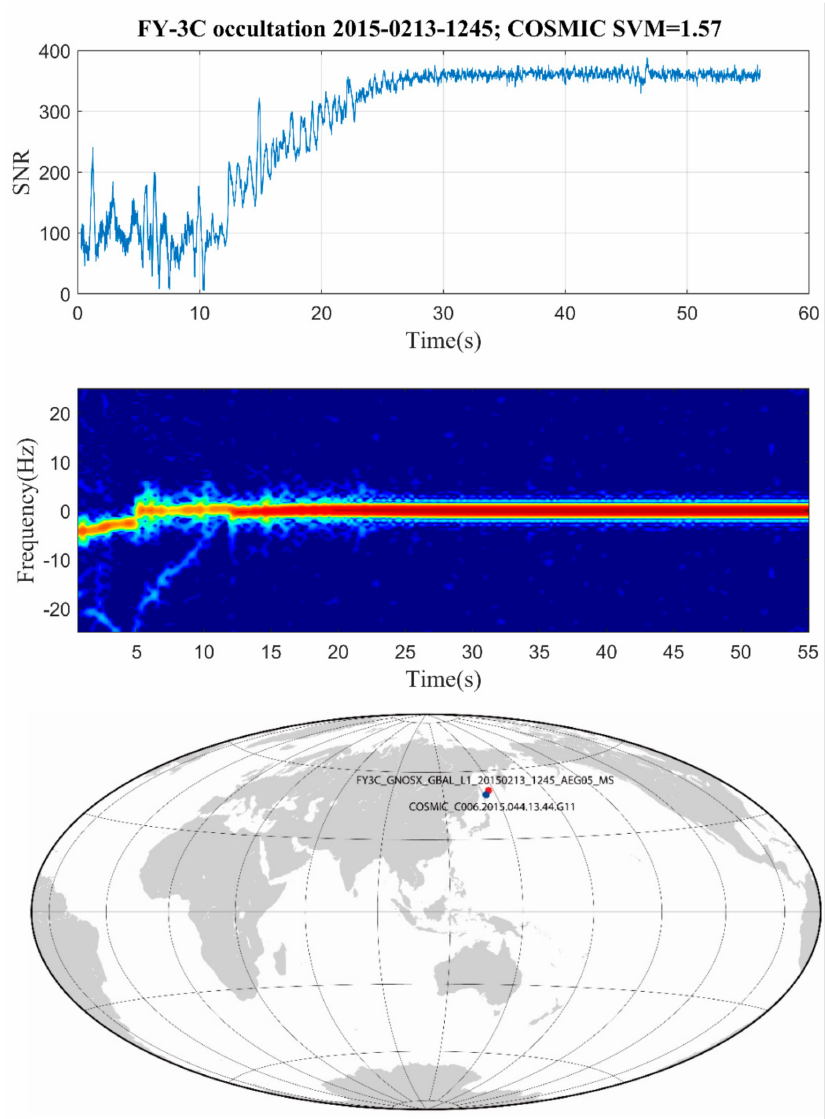
Figure 4. FY-3C event on 13 February 2015: received SNR of L1 channel ( upper panel), radio hologram spectrum from FY-3C Level_1 data ( middle panel), geographical location of FY-3C event ( bottom